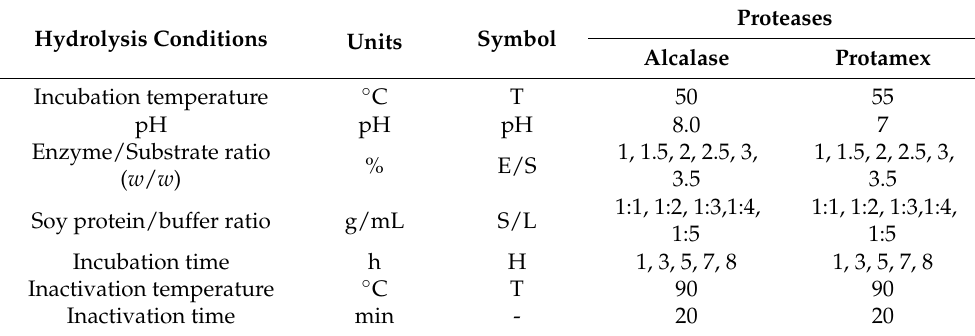
Table 4. Hydrolysis conditions for preparation of protein hydrolysates from